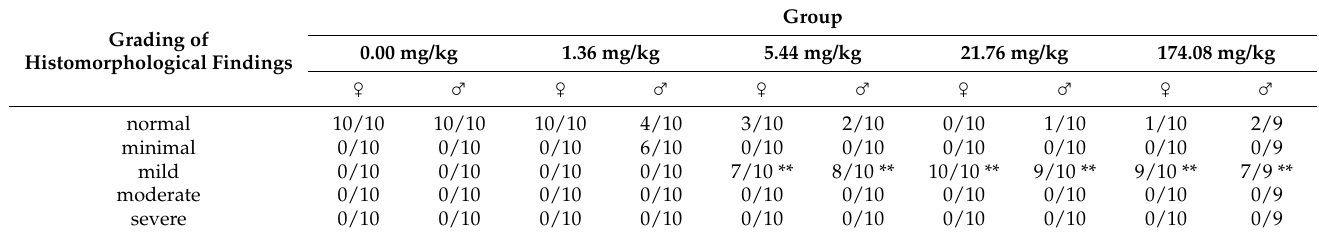
Table 6. Graded results of eosinophilic glassy droplet scoring in the kidneys of rats at the end of the AQ trial.